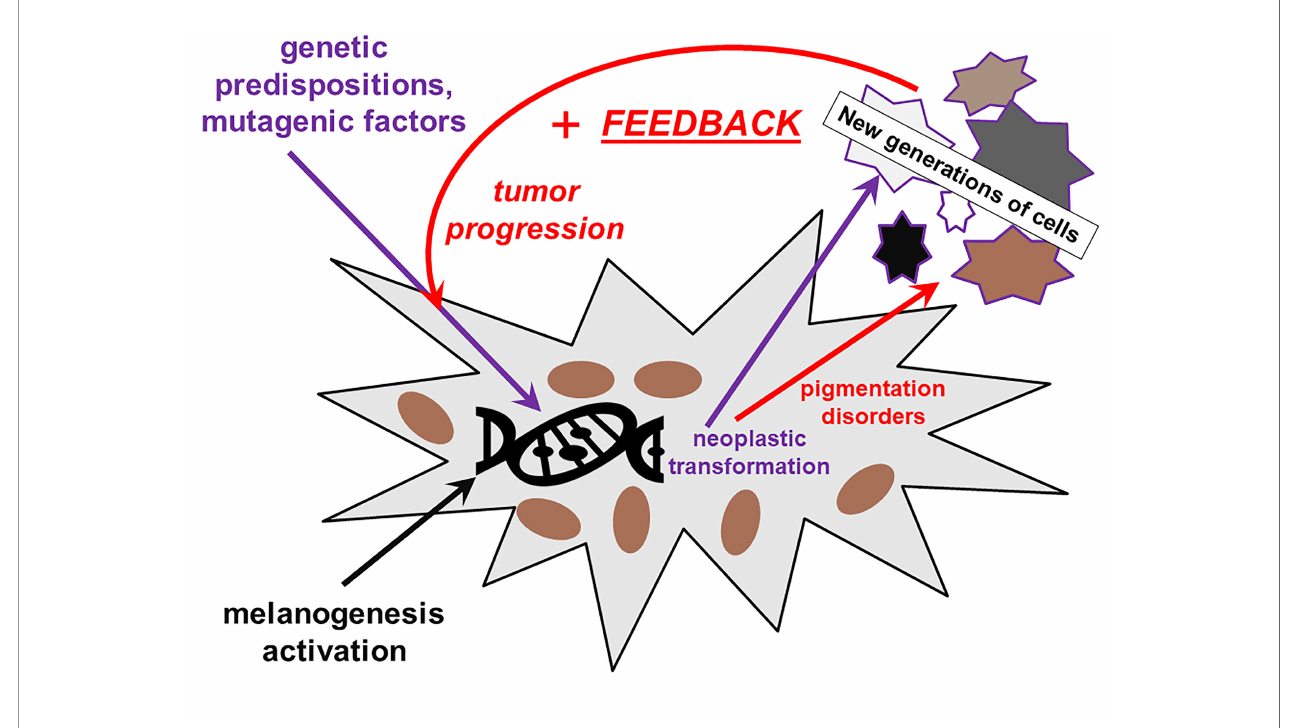
FIGURE 1 | The role of melanin and of impairment of melanin synthesis in the initiation and progression of melanoma. The defective melanin synthesis in connection with external factors (UV) and genetic predispositions plays a role in melanomagenesis in a positive feedback